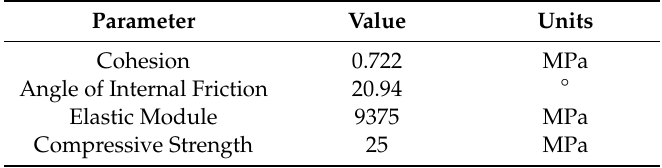
Figure 6. Estimated value shear stress–normal stress for limestone. Table 3. Results of the geomechanical properties of carbonate siltstone.